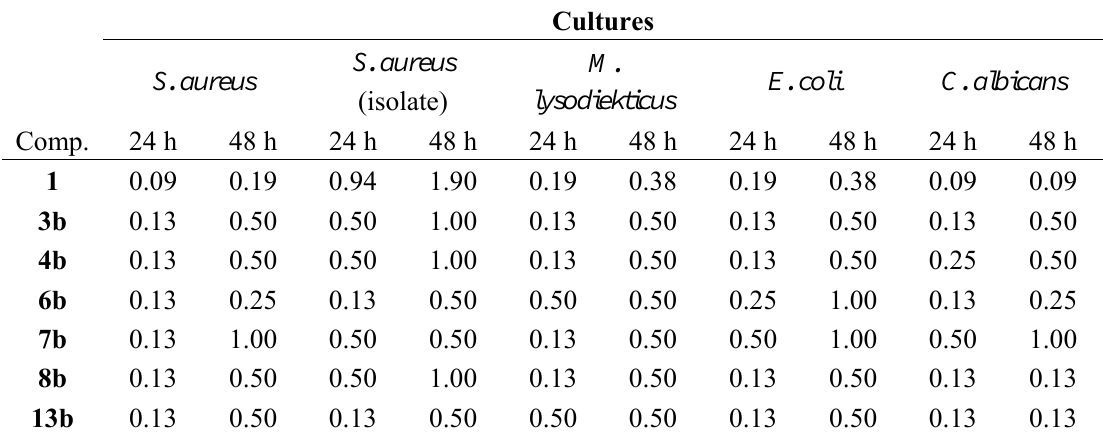
Table 4. MIC values (mg/mL) of the synthesized coumarin derivatives.